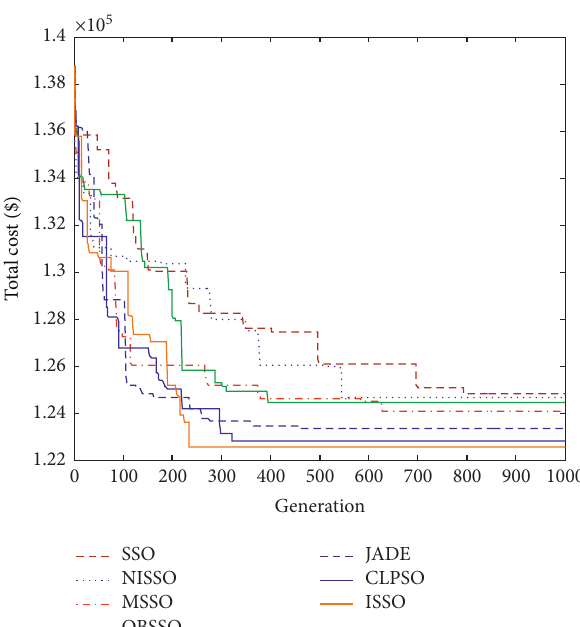
Figure 4: Convergence performance of the 40-unit